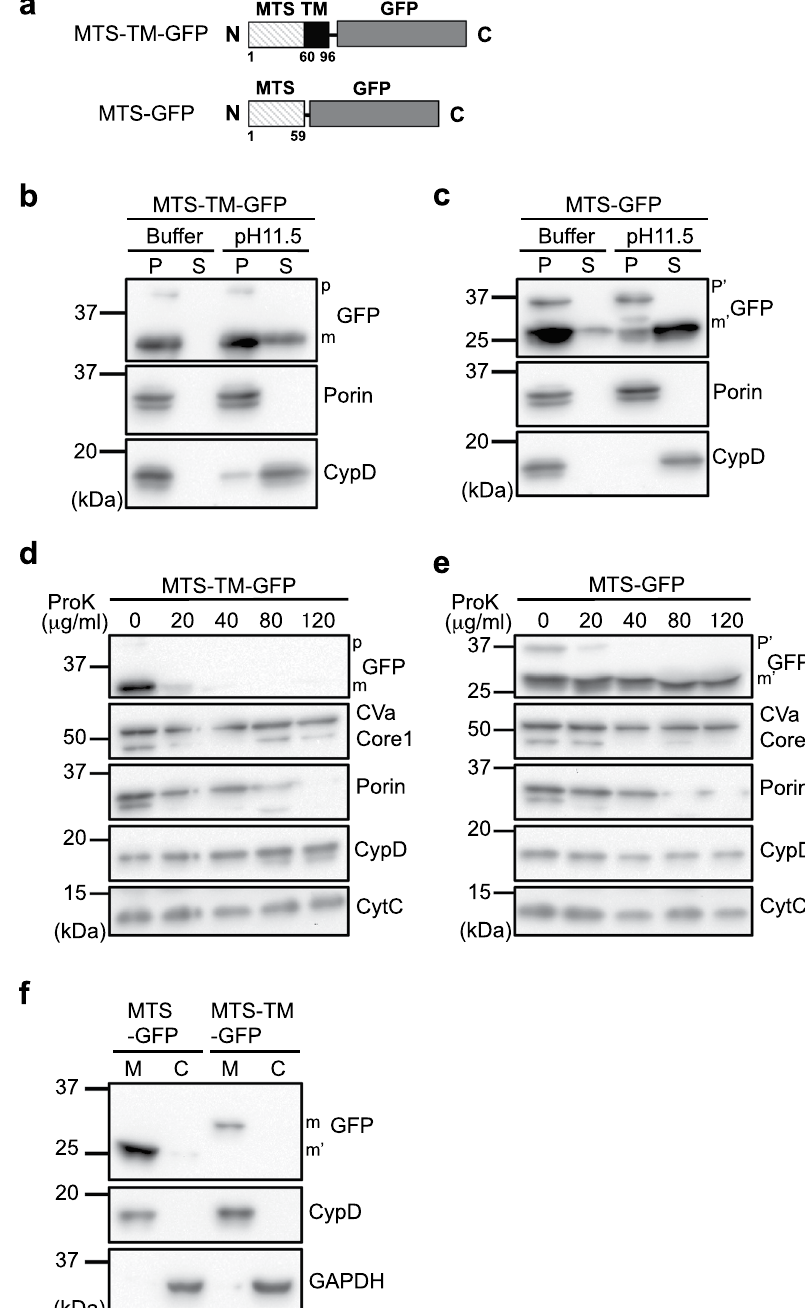
Figure 4. The MTS-TM segment in the N-terminus of StarD7 is sufficient for protein localization in the OMM. ( a ) Schematic of MTS-TM-GFP and MTS-GFP. In MTS-TM-GFP and MTS-GFP, MTS-TM and MTS are fused with GFP at the N-terminus, respectively. ( b and c ) Alkaline extraction assay. Mitochondria isolated from HEPA-1 cells transfected with MTS-TM-GFP ( b ) or MTS-GFP ( c ) were treated with isotonic buffer (Buffer) or alkaline buffer (pH 11.5), then the pellet (P) and supernatant (S) were separated by centrifugation, dissolved in the same volume of sample buffer, and the same volume of protein solutions were analyzed by Western blotting using anti-GFP, -porin and -CypD antibodies. ( d and e ) Proteinase K protection assays. Mitochondria isolated from HEPA-1 cells transfected with MTS-TM-GFP ( d ) or MTS-GFP ( e ) were treated with the indicated concentration of proteinase K (ProK). After separation by SDS-PAGE, GFP and mitochondrial marker proteins were analyzed by Western blotting using anti-GFP, -CVa, -Core1, -porin, -CypD and -CytC antibodies. p and m (p’ and m’) indicate the precursor and mature forms of the protein, respectively. ( f ) Mitochondria and cytosol were separated from cells transfected with MTS-GFP or MTS-TM-GFP by subcellular fractionation. M and C indicate mitochondria and cytosol,